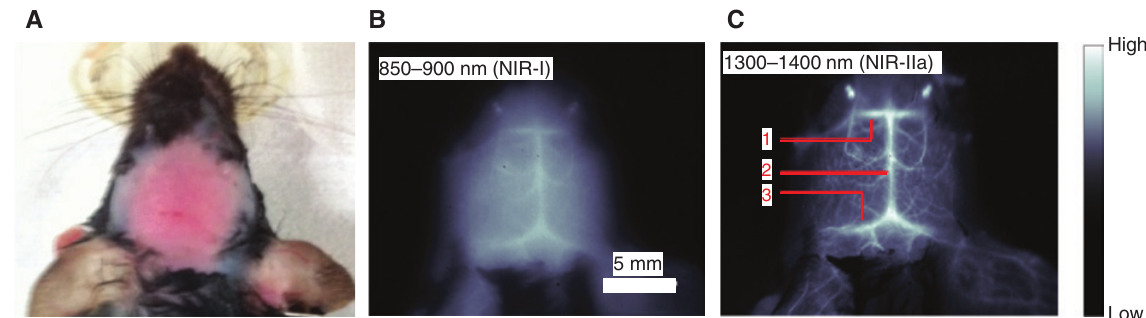
Figure 2: Imaging of deep tissue using a dual NIR-SWIR probe based on the dye IR800CW attached to single-walled carbon nanotubes (SWCNs): (A) C57Bl/6 mouse head with hair removed; (B ) fluorescent images of the same mouse at 850–900 nm, (C) 1300–1400 nm. Red arrows point to specific locations in the brain that can be resolved (with permission from [40]).